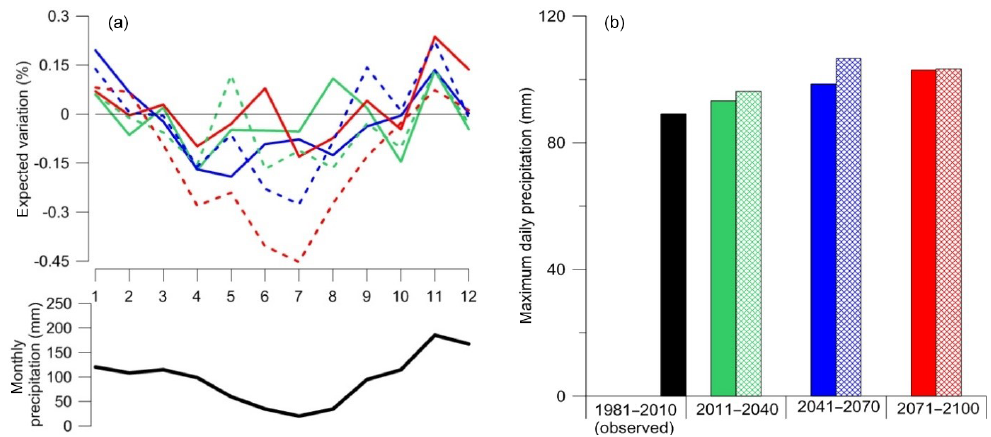
Figure 5. (a) expected variations in monthly cumulative variations and (b) mean values of maximum daily precipitation. The joint probability P